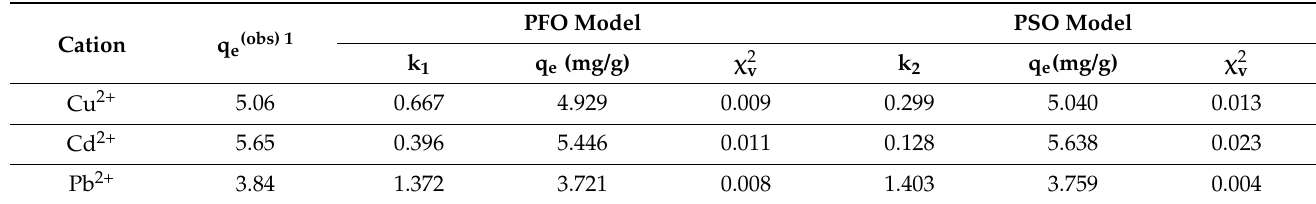
Table 2. Multi-component (competitive) adsorption kinetics: kinetic models and parameters for simultaneous adsorption of Cu 2+ , Cd 2+ and Pb 2+ cations onto the oxidized wool fibers;